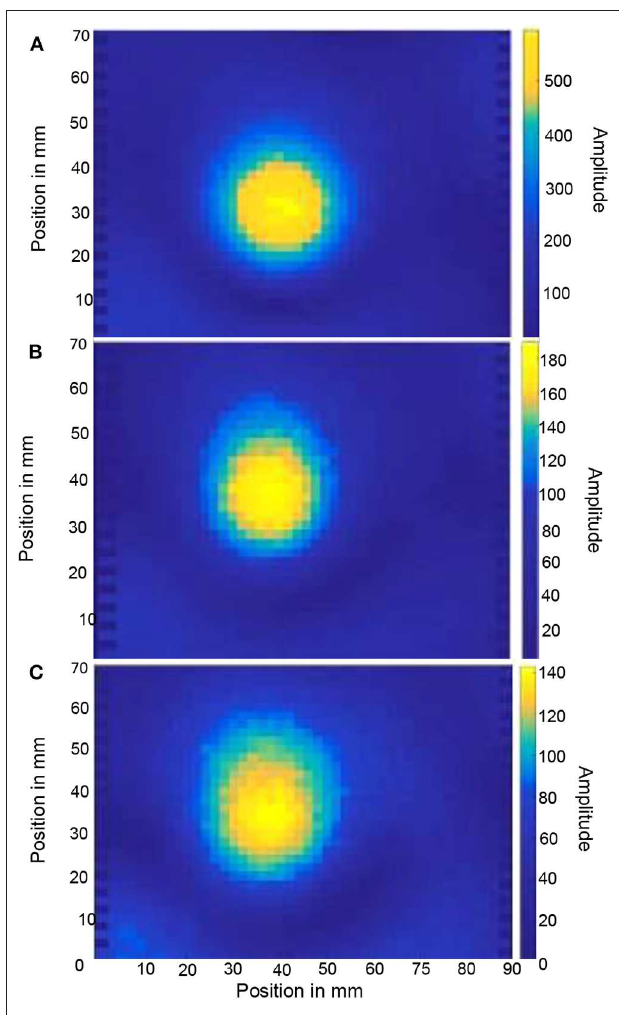
FIGURE 4 | RACE FBH images at various receiver heights: (A) 0.5mm; (B) 4mm; (C)